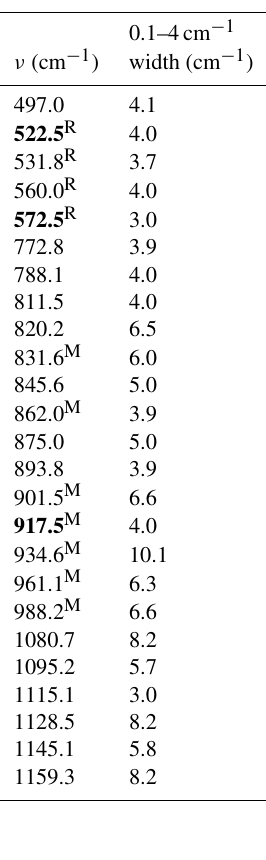
Table 2. Microwindows used in the optical and microphysical cloud property retrievals. The first column gives the central wavenumber, and the second column gives the microwindow width for resolutions of 0.1 to 4cm − 1 . For resolutions of 8cm − 1 , some microwindows were widened slightly so that there was at least one point in the mi- crowindow (a few were narrowed so that there was only one point). Two sets of microwindows were used in this work: a combination of those used by Rathke and Fischer (2000) and Mahesh et al. (2001), indicated with superscripts R and M , and microwindows similar to those used by Turner (2005), consisting of all wavenumbers in plain font (e.g., not